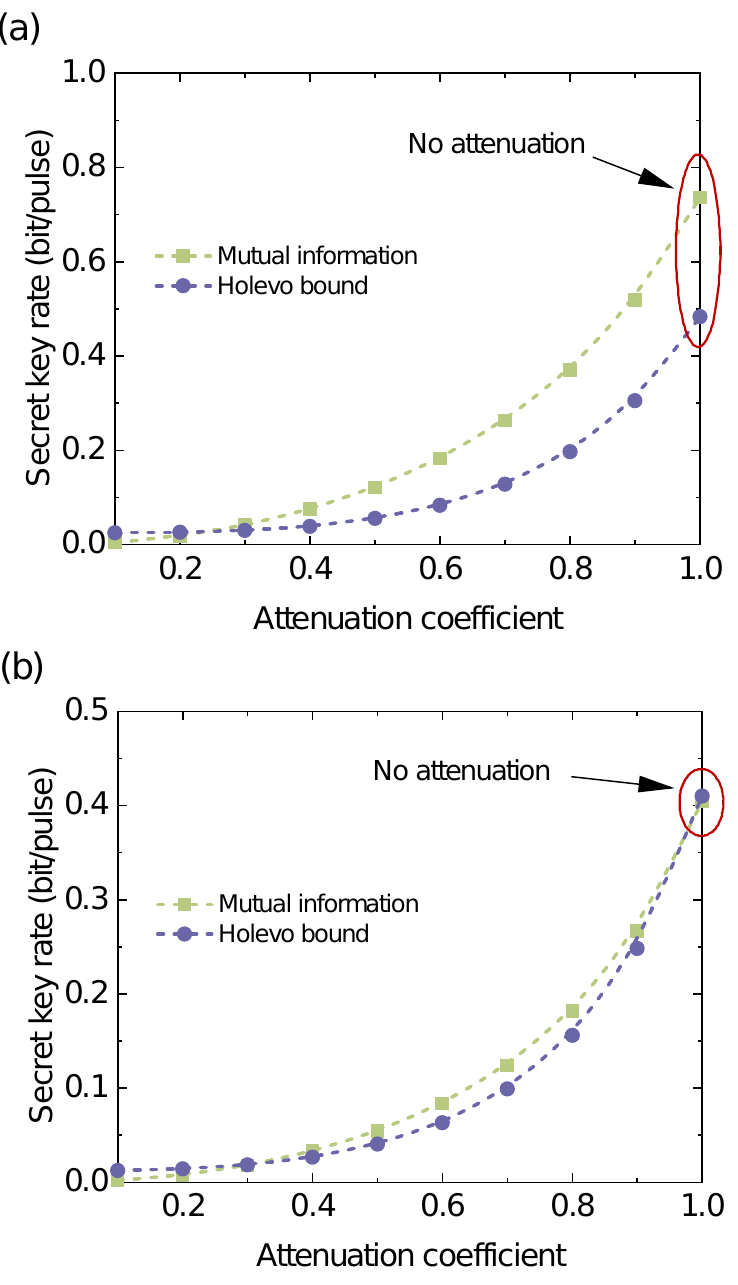
Figure 7. The reconciliation-stricken mutual information (green line) and Holevo bound (purple line) vs. attenuation coefficient for the zenith angles: ( a ) ζ = 0 ◦ ; ( b ) ζ = 32 ◦